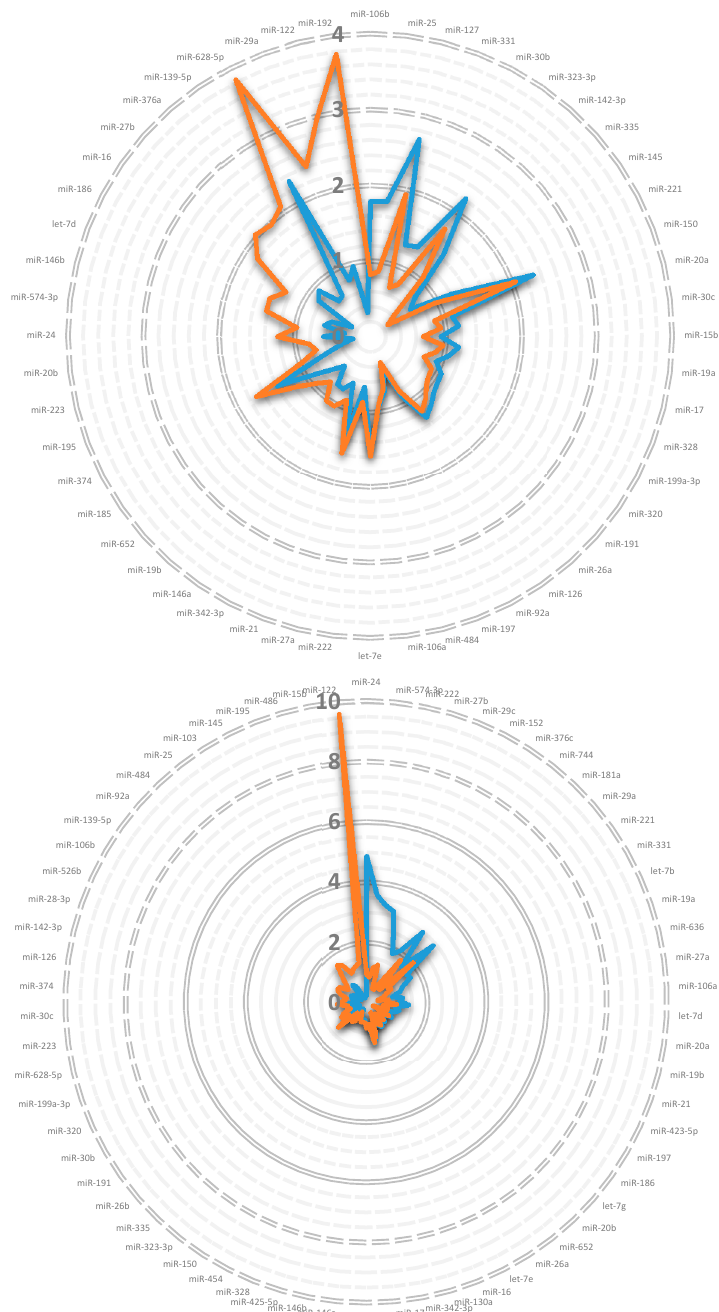
Figure 1. miRNA profile in serum and high-density lipoprotein (HDL) particles of chronic renal failure (CRF) and hemodialysis patients. Pooled serum and HDL particles of adult CRF (top) and hemodialysis patients (bottom) and their matched controls was analyzed by the TaqMan™ miRNA array A (duplicates). From the 381 different miRNAs, 57 (serum) and 90 (HDL particles) for CRF patients and 75 (serum) and 89 (HDL particles) for hemodialysis patients were detectable (plotted were only miRNAs detectable in serum and HDL particles) and the relative quantitation (RQ) was calculated subsequently (the corresponding control miRNAs were set to RQ = 1). RQ-values were arranged in the following manner: starting at the twelve o’clock position with the maximum negative difference between the RQ values of HDL particles (orange) and serum (blue), the values increase clockwise (reaching nearly equality at the six o’clock position) and reach the maximum positive difference before closing the circle again (see Table A2 (in Appendix A) for the complete data set).